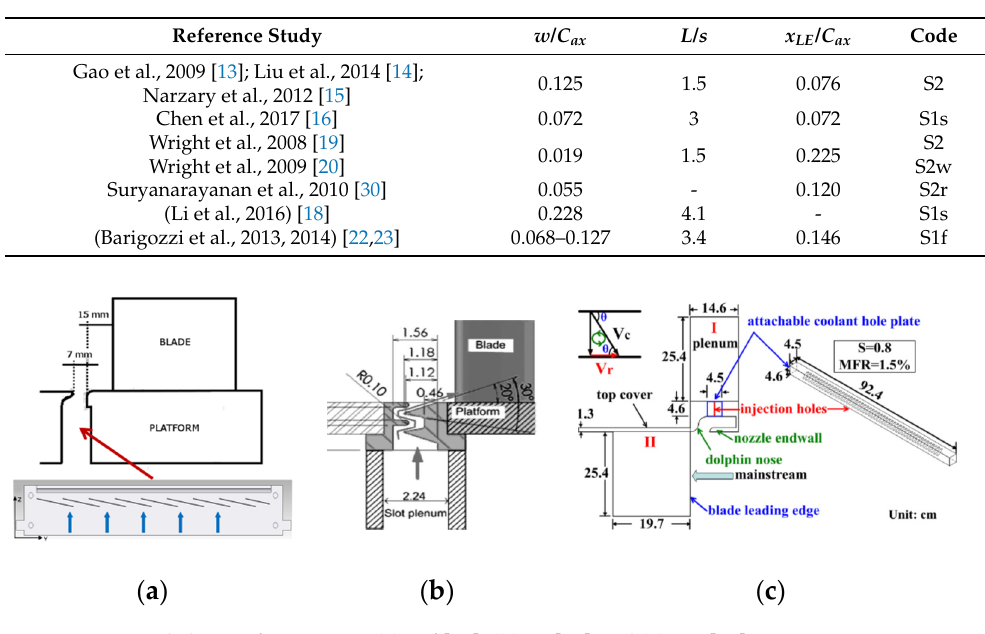
Table 1. Typical slot geometry and details of purge flow supply system.